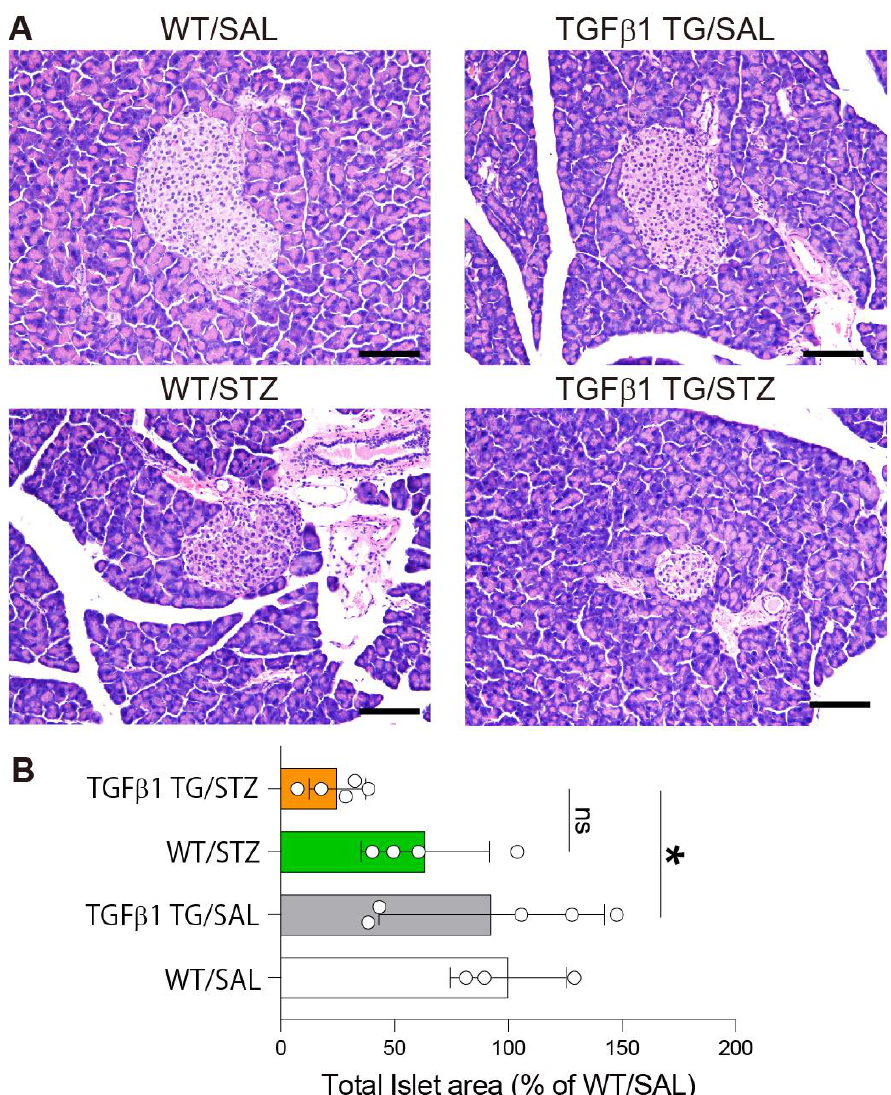
Figure 4. Diabetic transforming growth factor β 1 mice have a decreased area of pancreatic islets. ( A ) Mice were sacrificed in week 9 after streptozotocin or saline intraperitoneal injection. The pancreas was incised, removed, and prepared for hematoxylin and eosin staining. ( B ) Area of pancreatic islets measured in each group using the WinROOF image processing software. Number of mice: WT/SAL n = 3, TGF β 1 TG/SAL n = 5, WT/STZ n = 4, TGF β 1 TG/STZ n = 5. Scale bars indicate 200 µm. Data are the mean ± S.D. Statistical analysis by ANOVA with Newman – Keuls ’ test. * p < 0.05; ns, not significant.